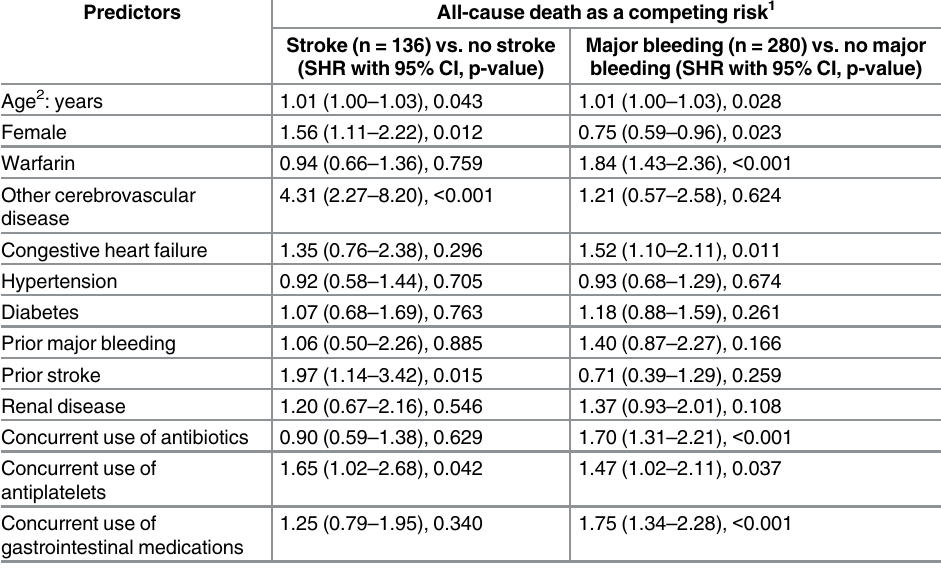
coefficients as the original models, indicating internal model validation ( Tables 4 and 5 ). Find- ings from 10-fold cross-validation also produced similar AUCs to the original PLR model: 0.69 for stroke and 0.71 for major bleeding ( Table 7 ). For external validation in the KPCO-II cohort, the models ’ intercepts and the regression coefficients were updated ( S4 Table ). Results Table 6. Sensitivity analysis results from competing risk analysis for stroke and bleeding based on survival analysis in KPCO-I cohort.